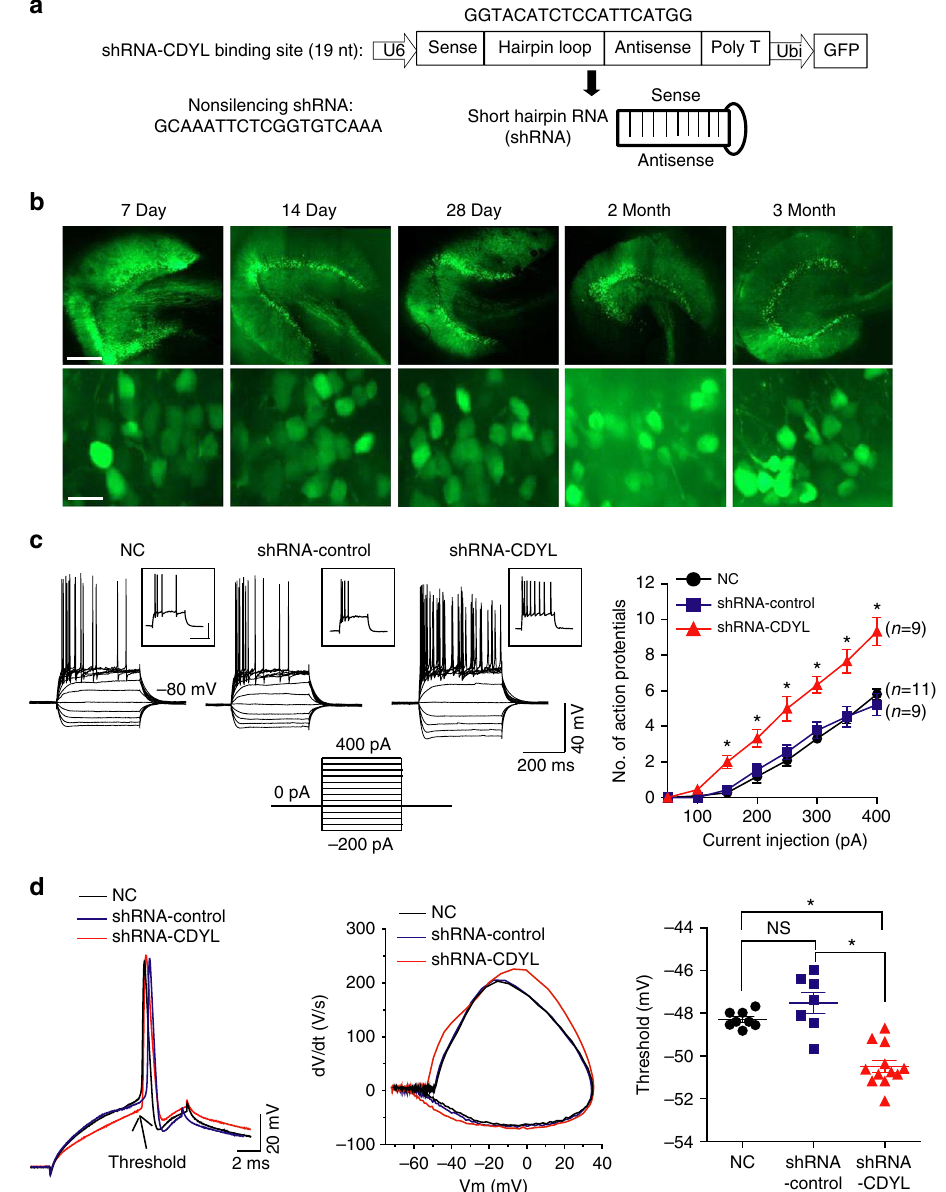
Fig. 2 Knockdown of CDYL signi fi cantly enhanced neuronal intrinsic excitability. a A schematic diagram showing the lentiviral shRNA expression vector system. The 19 nuleotide shRNA is speci fi c to the rat/mouse CDYL mRNA. b Expression of lentivirus over time in the dorsal hippocampal DG area. Rats infused with lentivirus were transcardially perfused on day 7, 14, 28, 60, 90 after infusion (days post infusion, DPI). Scale bar , 500 μ m ( upper ), 15 μ m ( bottom ). c Representative current-clamp recordings obtained from normal control (NC), CDYL-shRNA-infected and nonsilencing-shRNA-infected rat DG neurons ( left ). A series of 400 ms hyperpolarizing and depolarizing steps in 50 pA increments were applied to produce the traces. For comparison reasons, the cells were held at − 80 mV of membrane potential. The mean number of action potentials generated in response of depolarizing current pulses were shown in the right panel. * p < 0.05, one-way ANOVA with Bonferroni ’ s multiple-comparison test. d Typical spikes ( left ), associated phase plane plots ( middle ) and the average spike threshold ( right ) obtained from control, CDYL-shRNA-infected and nonsilencing-shRNA-infected rat DG neurons. * p < 0.05, one-way ANOVA with Bonferroni ’ s multiple-comparison test. Data were represented as mean ±